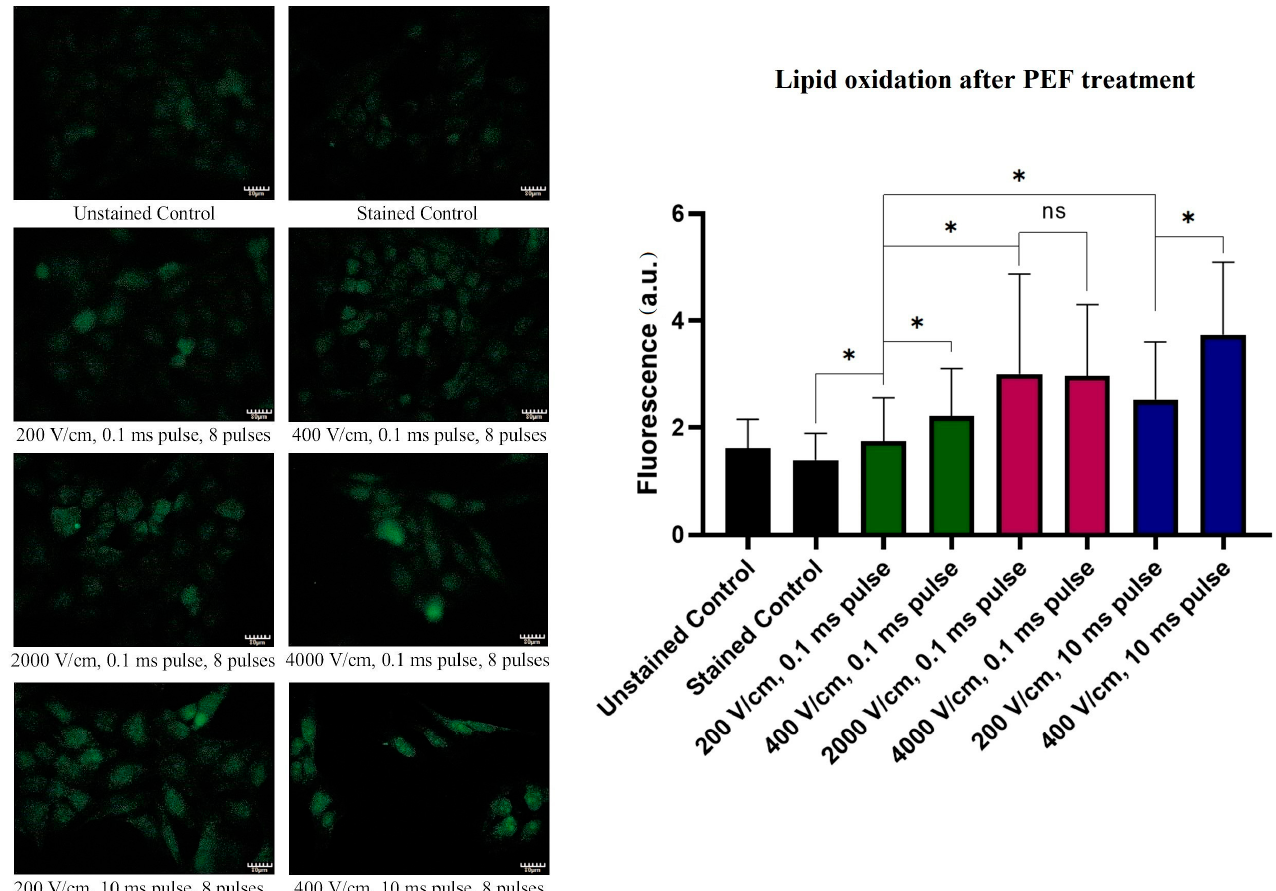
Figure 7. Lipid oxidation induction 36 h after electroporation. The left panel depicts representative fluorescent photographs of the cells stained with the Click-iT TM kit. On the right panel, the statistical analysis of the samples is provided. Green bars represent 200–400 V/cm, 0.1 ms pulses; blue bars represent 200–400 V/cm, 10 ms pulses; red bars represent 2–4 kV/cm, 0.1 ms pulses. The fluorescence is presented as the mean ± SD. One-way ANOVA analysis: * p < 0.05, ns p > 0.05. Scale bar—80 µ m.